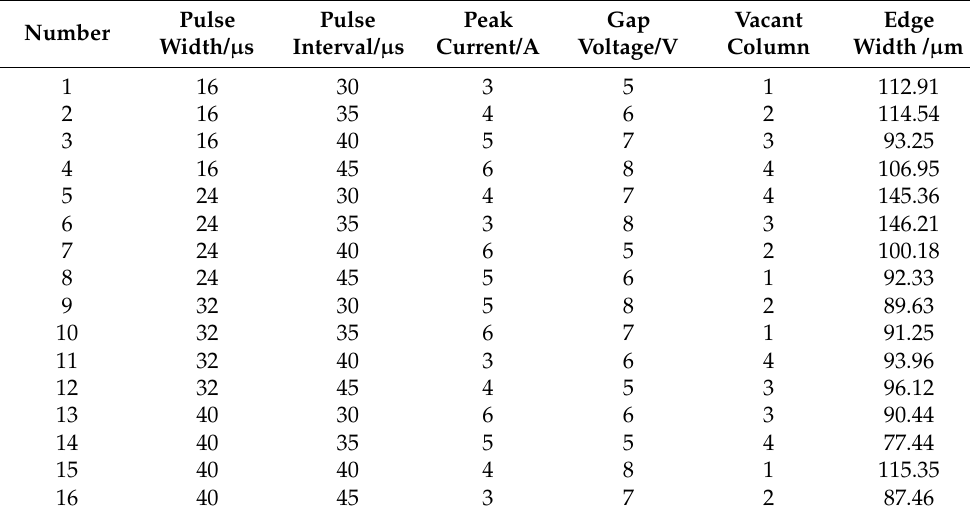
Table 2. Four-factor and four-level orthogonal test data